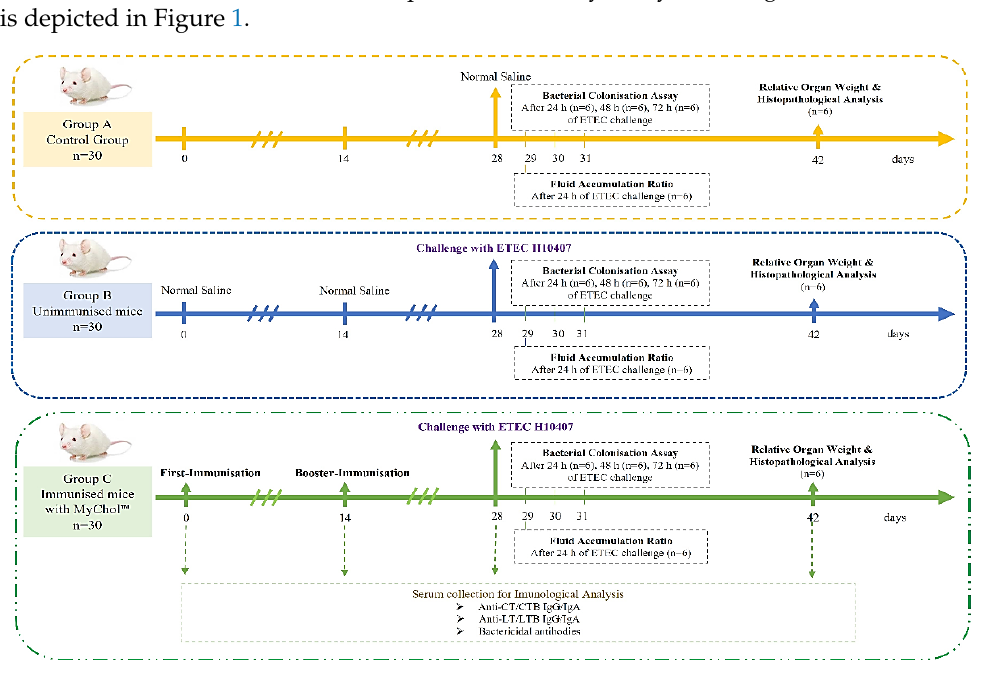
Figure 1. Flow diagram of evaluation of cross-protection efficacy of MyChol™ against ETEC H10407 in BALB/c mice.